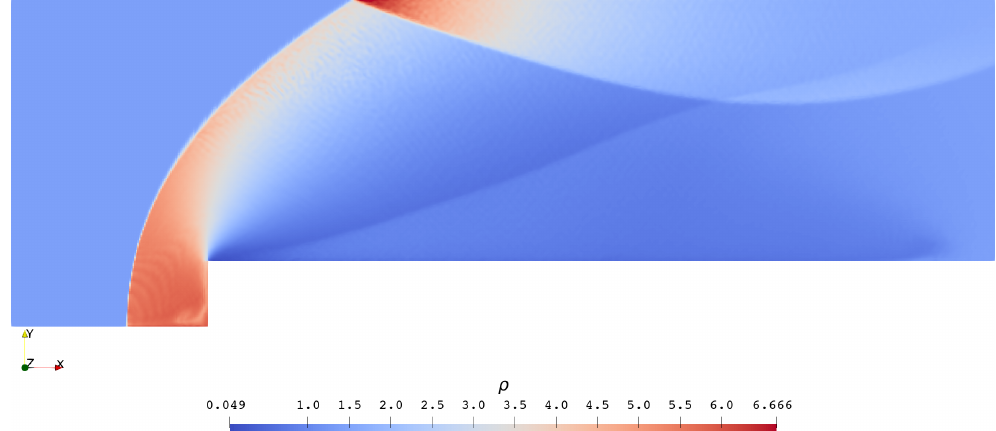
Figure 12. Third-order solution of Problem 4 at t = 0.8 on an h = 1/200 mesh.